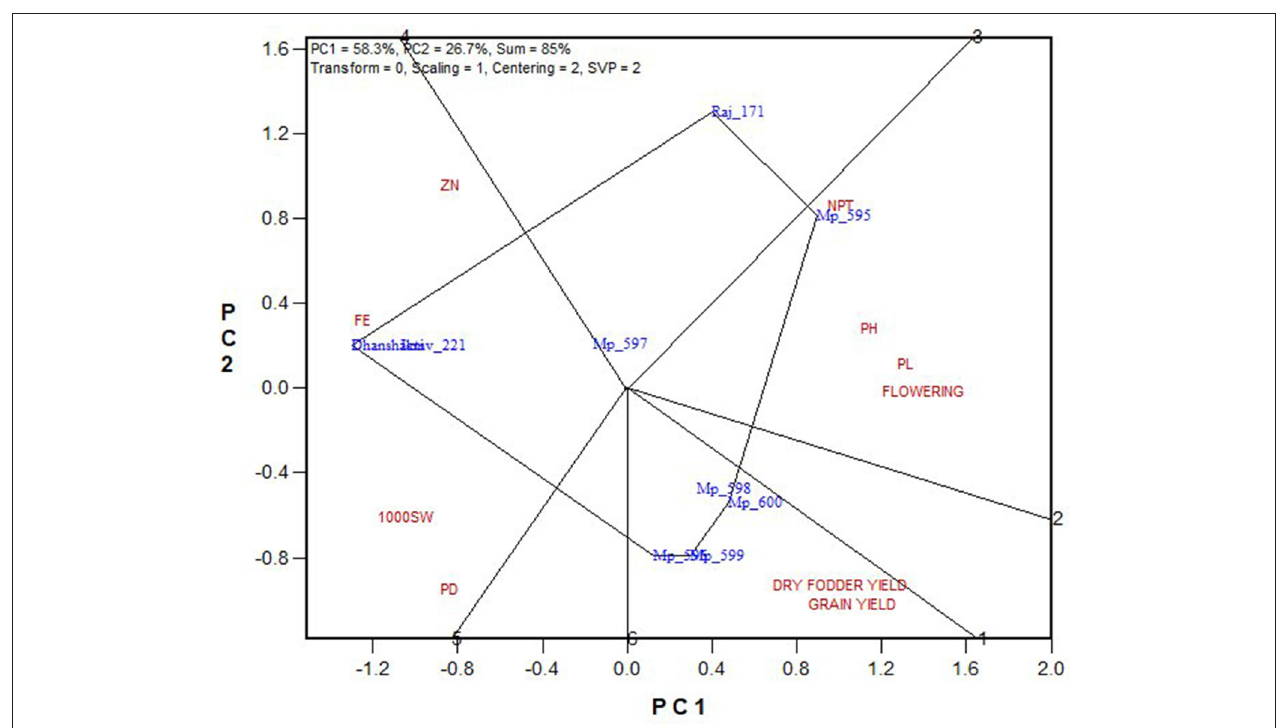
FIGURE 7 | Polygon view of GT biplot indicating which is the best genotype for the target